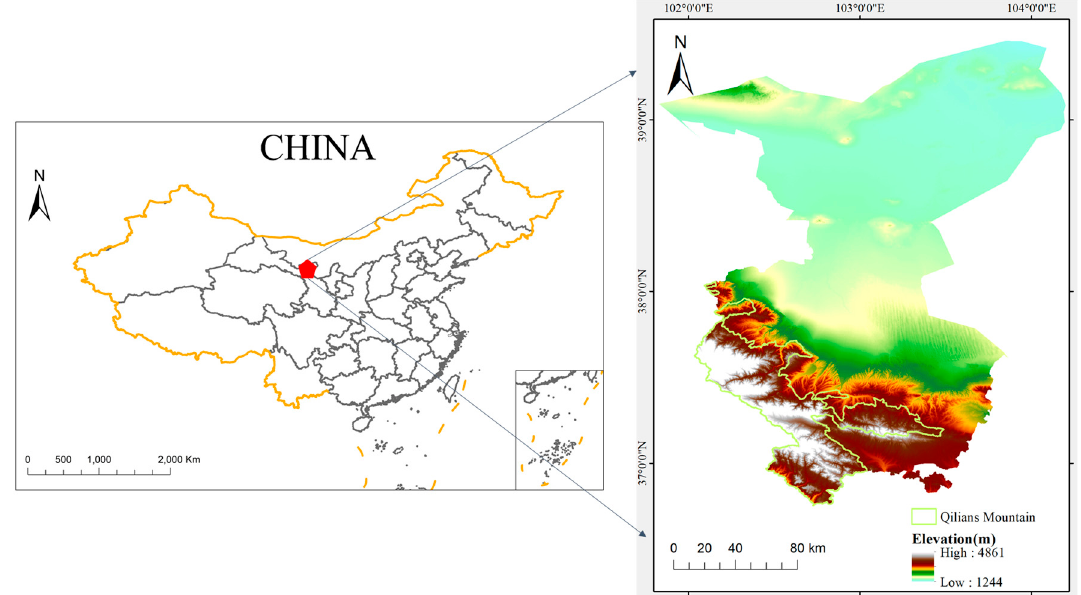
Figure 1. Location of the study area. The green line in the right part is the boundary of Qilian Mountain National Nature Reserve in Wuwei.